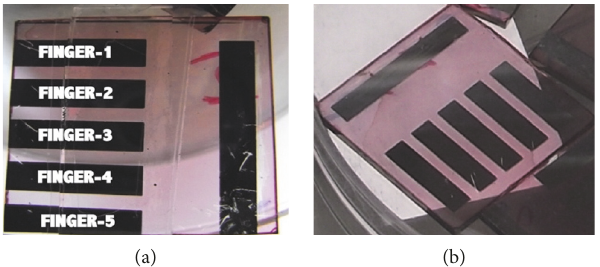
Figure 6: Organic cell and its fi ngers before (a) and after (b) the degradation